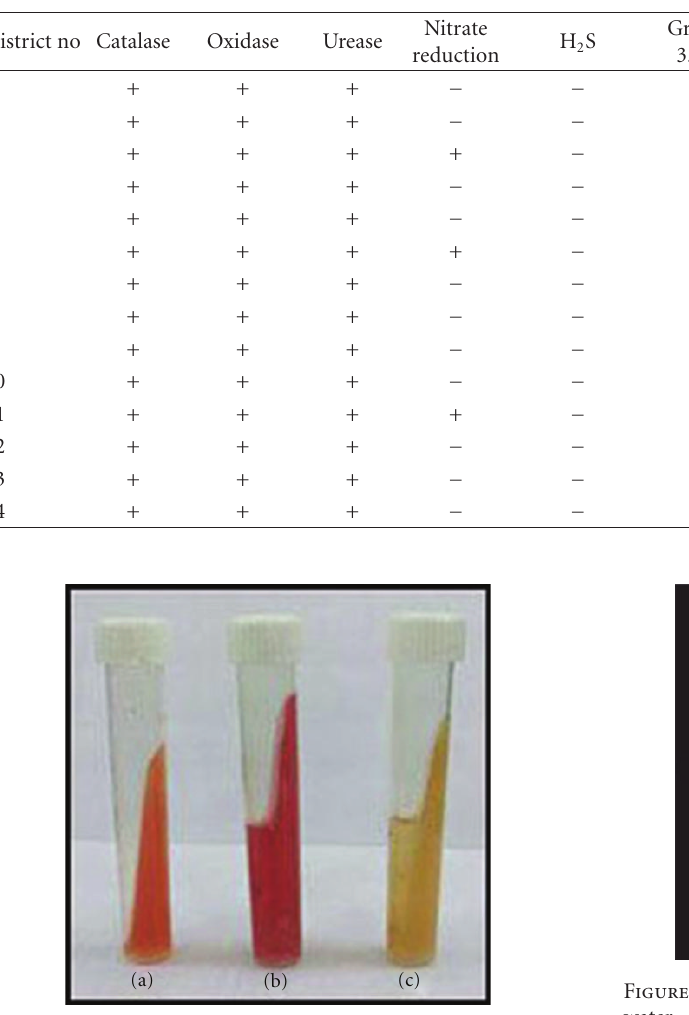
Figure 1: Change in color of slant MCUA tube, (a) slant MCUA tube only, (b) positive slant MCUA tube, culture, (c) negative slant MCUA tube, culture.